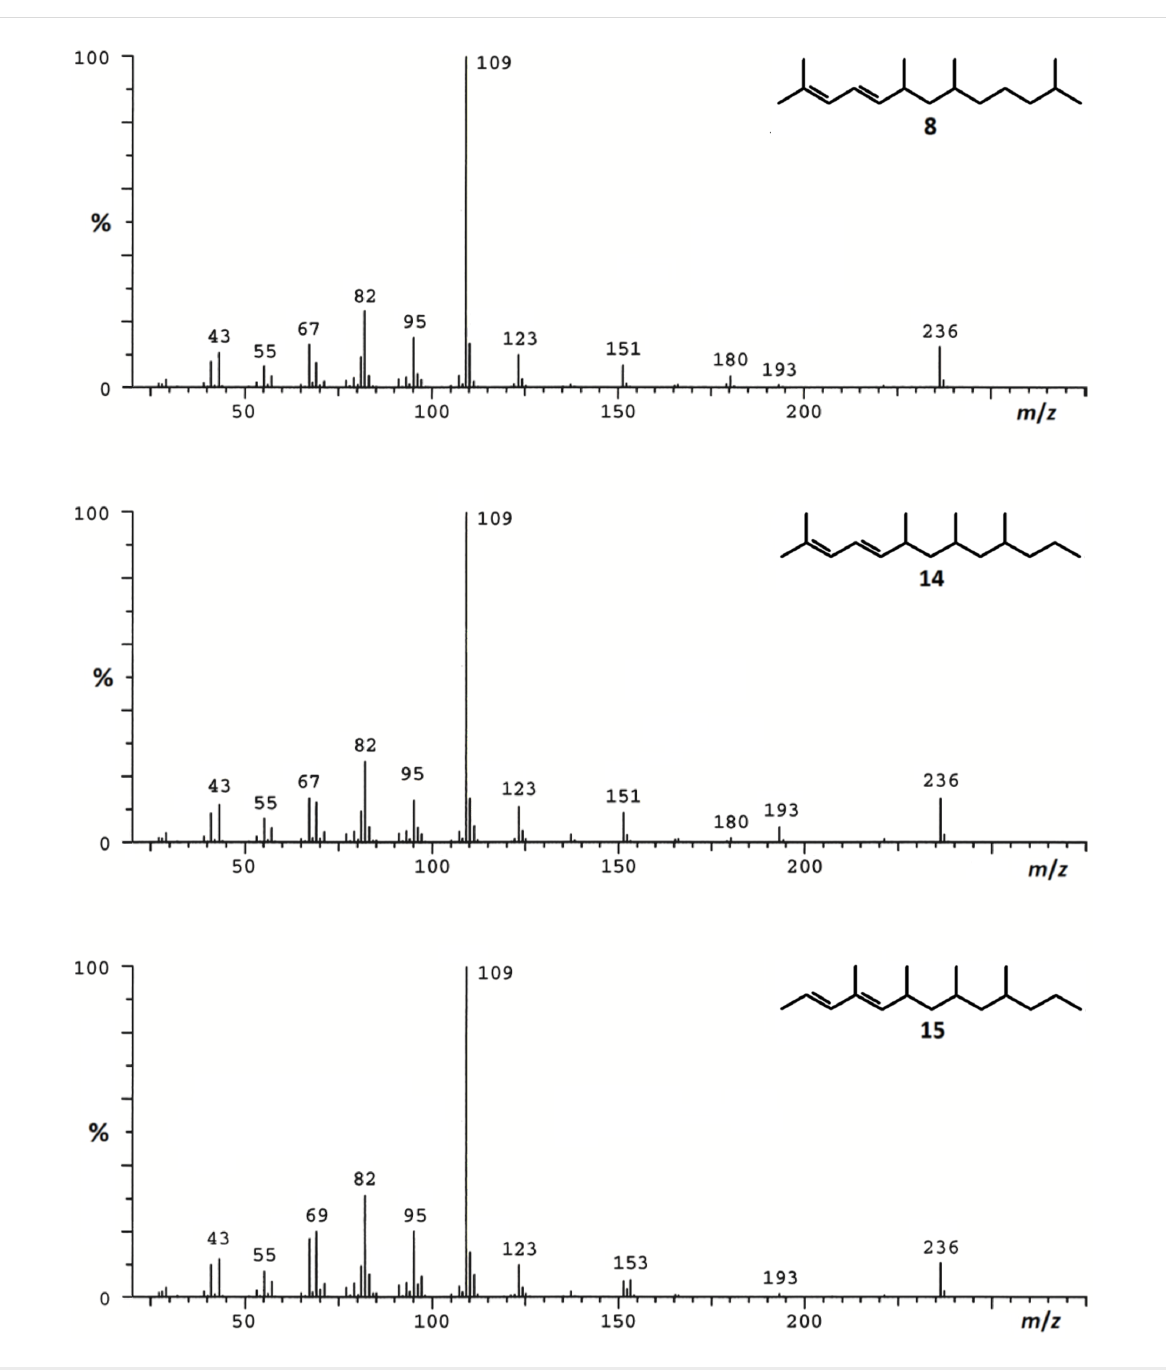
mation File 1. Starting from 12 and following the sequence described for the transformation of 6 to 8 , a mixture of the stereoisomers of the target diene 14 was obtained via 2,4,6- trimethylnonanal ( 13 ) [15]. GC–MS-analysis of this mixture revealed a 3:1 dominance of the E -configurated racemates over the earlier eluting Z -series. The chromatogram showed seven